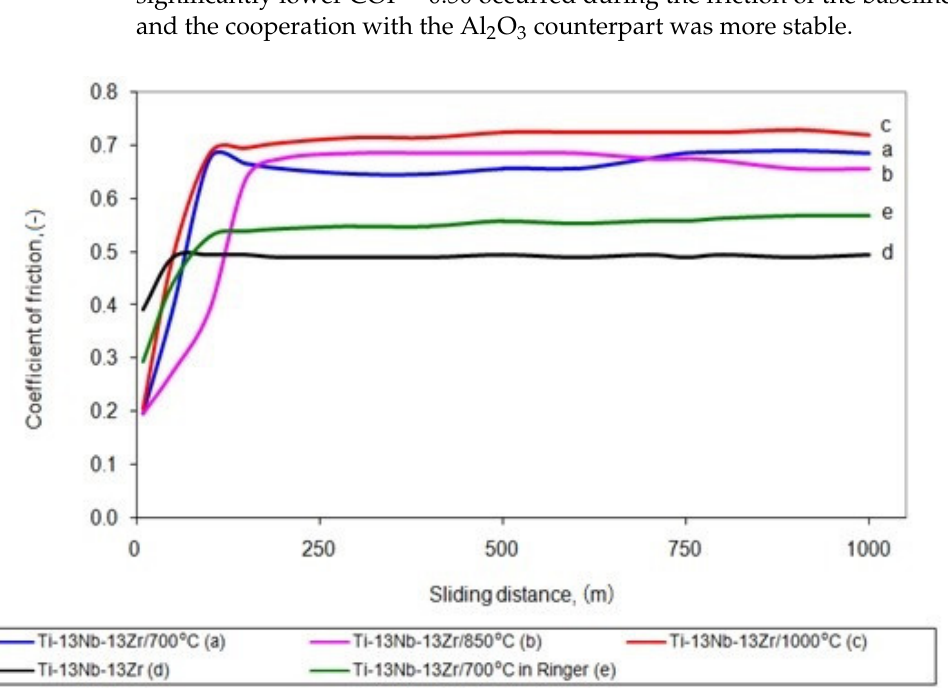
Figure 6. COF of the alloy oxygen hardened at 700 °C ( a ), 850 °C ( b ) and 1000 °C ( c ) compared to as-received alloy ( d ) in dry friction condition as well as the alloy hardened at 700 °C in Ringer’s solution ( e ) against alumina ball.